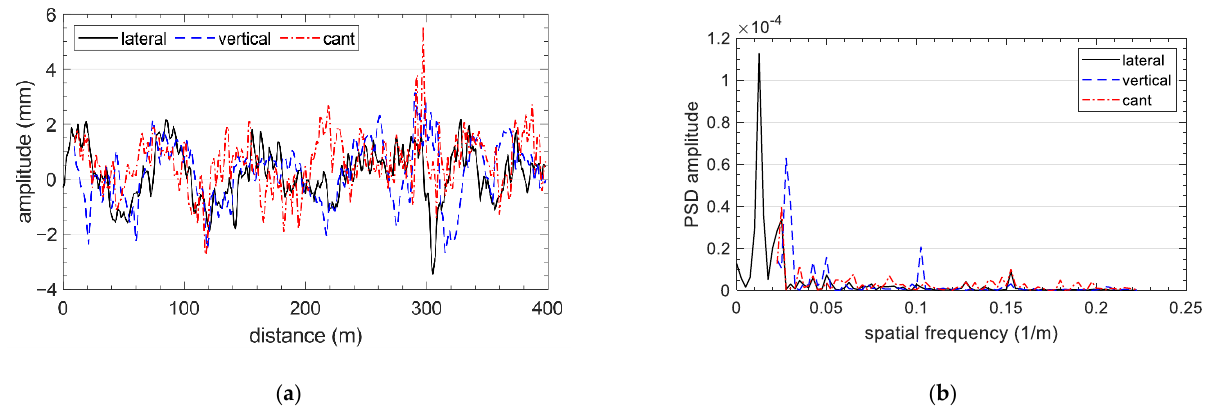
Figure 5. Track geometric irregularities ( a ) Power spectral density of the track irregularities ( b